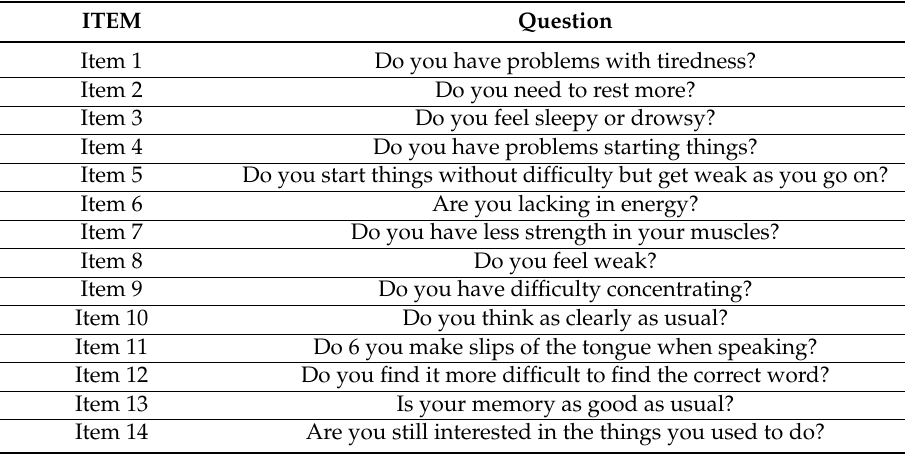
Table 1. The questions of Chalder Fatigue Scale